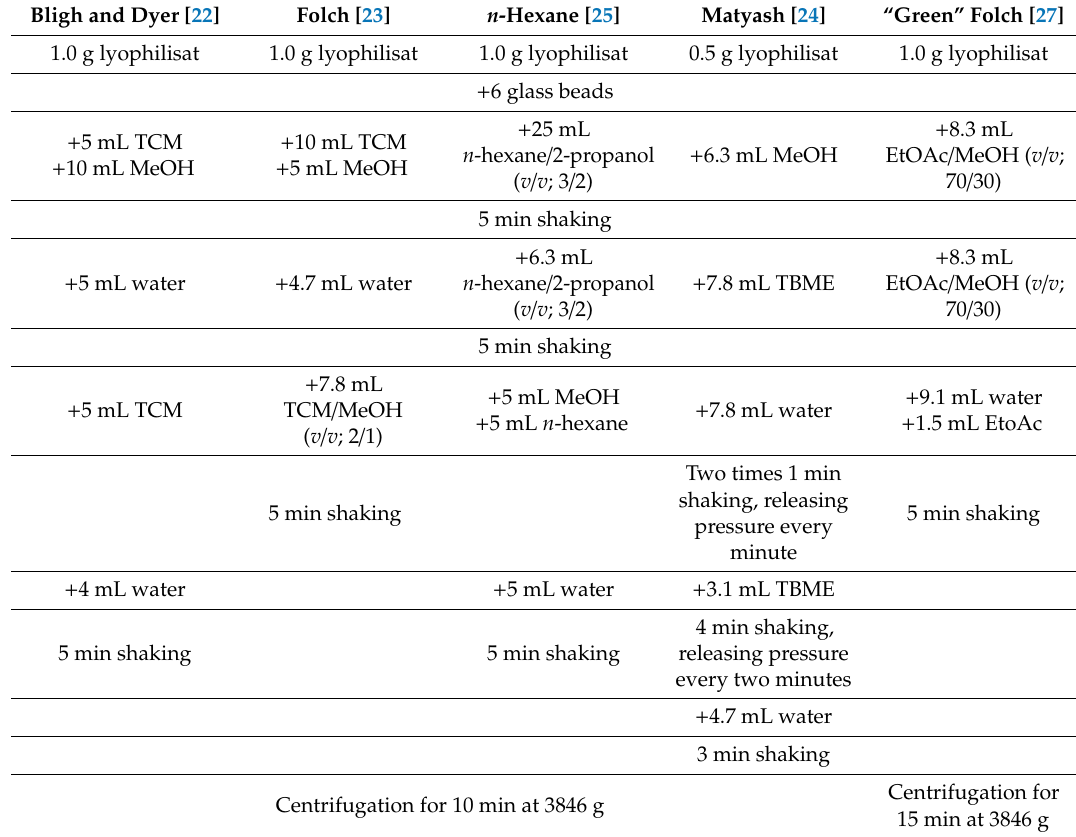
Table 1. Procedures of five biphasic extraction methods to enrich polar lipids (all organic solvents contained 50 µ g / mL 3,5-di-tert-butyl-4-hydroxytoluol (BHT) and 0.1% formic acid (FA); water included 0.1% FA). TCM: